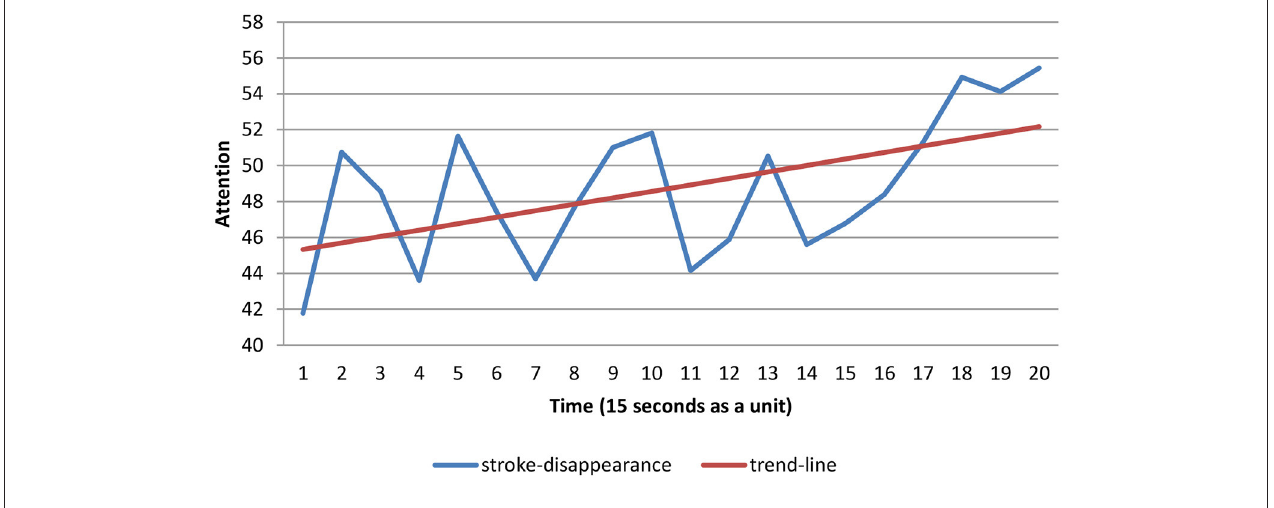
FIGURE 2 | Time series chart of stroke-disappearance.